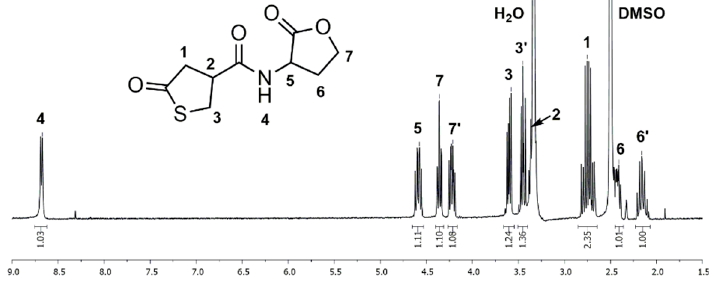
Figure 1. 1 H NMR spectrum of the thiolactone-lactone ( 1 ) measured in Deuterated dimethyl sulfoxide (DMSO- d 6 ).